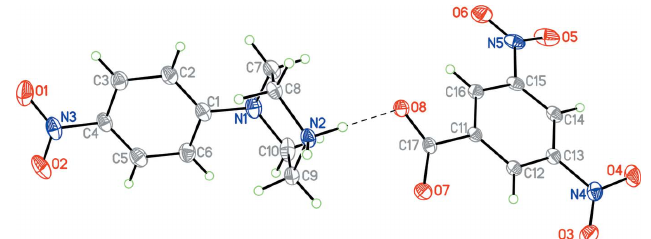
Figure 3 Diagram showing atom labelling and the arrangement of cation and anion in 3 (only major component shown). Hydrogen bonds are shown by dashed lines. Atomic displacement parameters are at the 30% probability level.